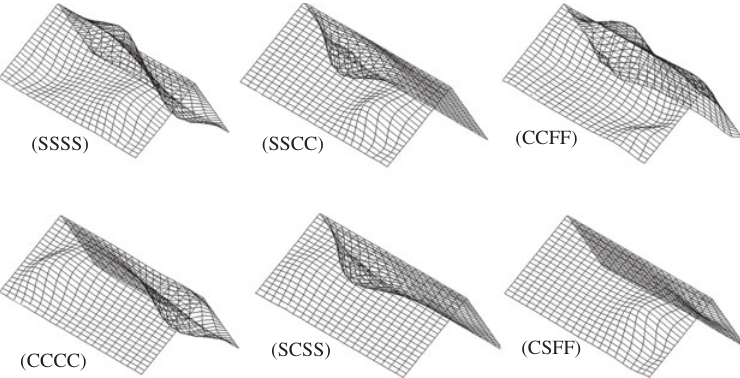
Figure 9 Thermal buckling modes for different boundary conditions of one-fold laminated plates.